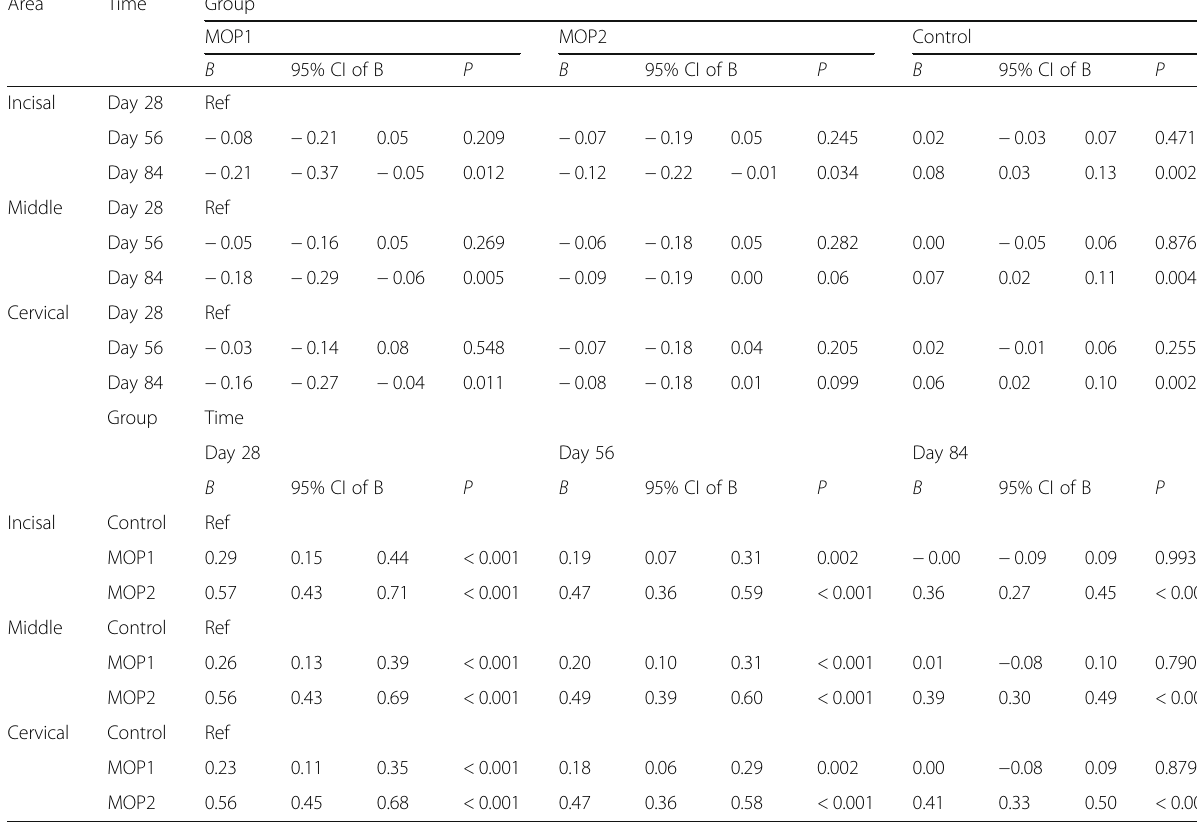
Table 3 Model coefficient, its 95% confidence interval and P value of the canine movement